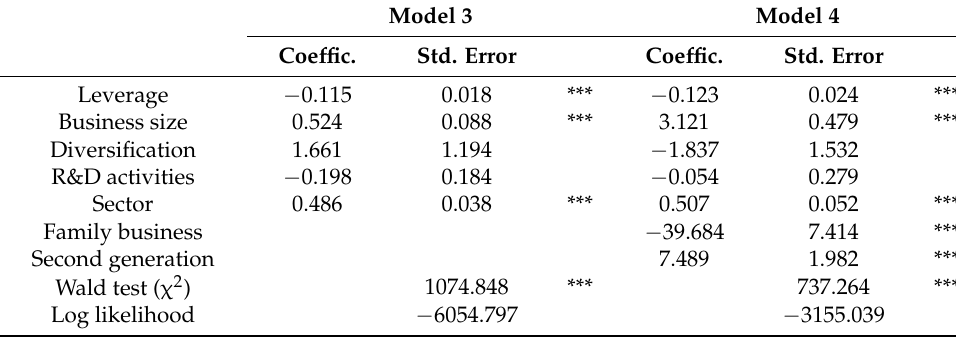
Table 5. Regression models. Internationalization Starting from Local